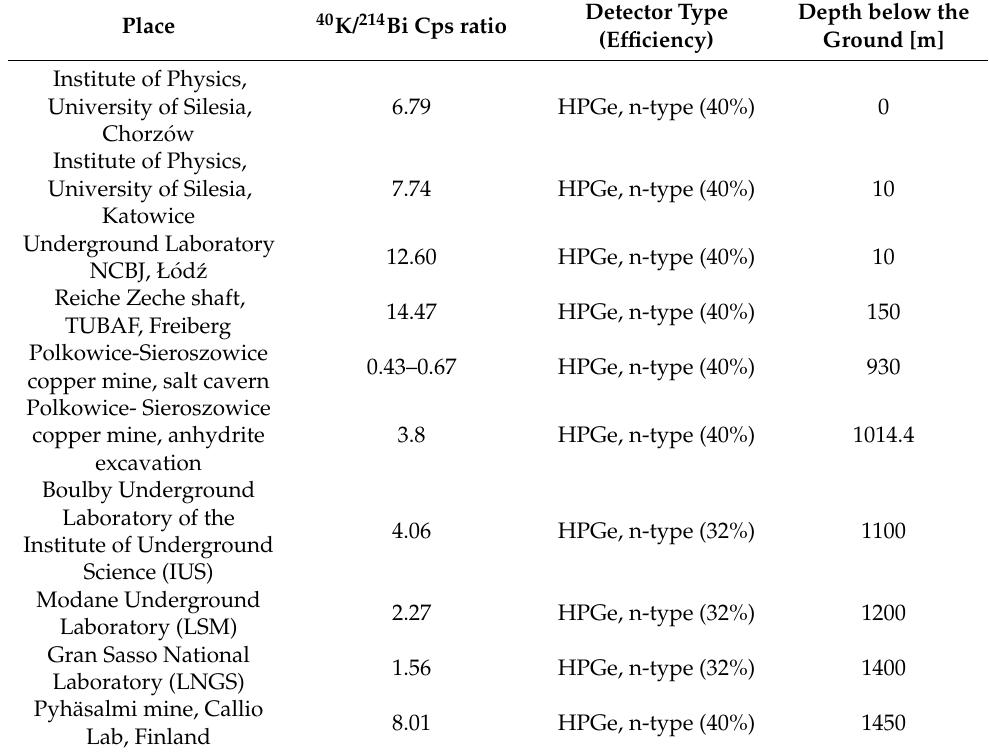
Table 3. The ratio of 40 K/ 214 Bi (1460.8 keV/1764.5 keV) count rates as a function of depth below the ground. Place 40 K/ 214 Bi Cps ratio